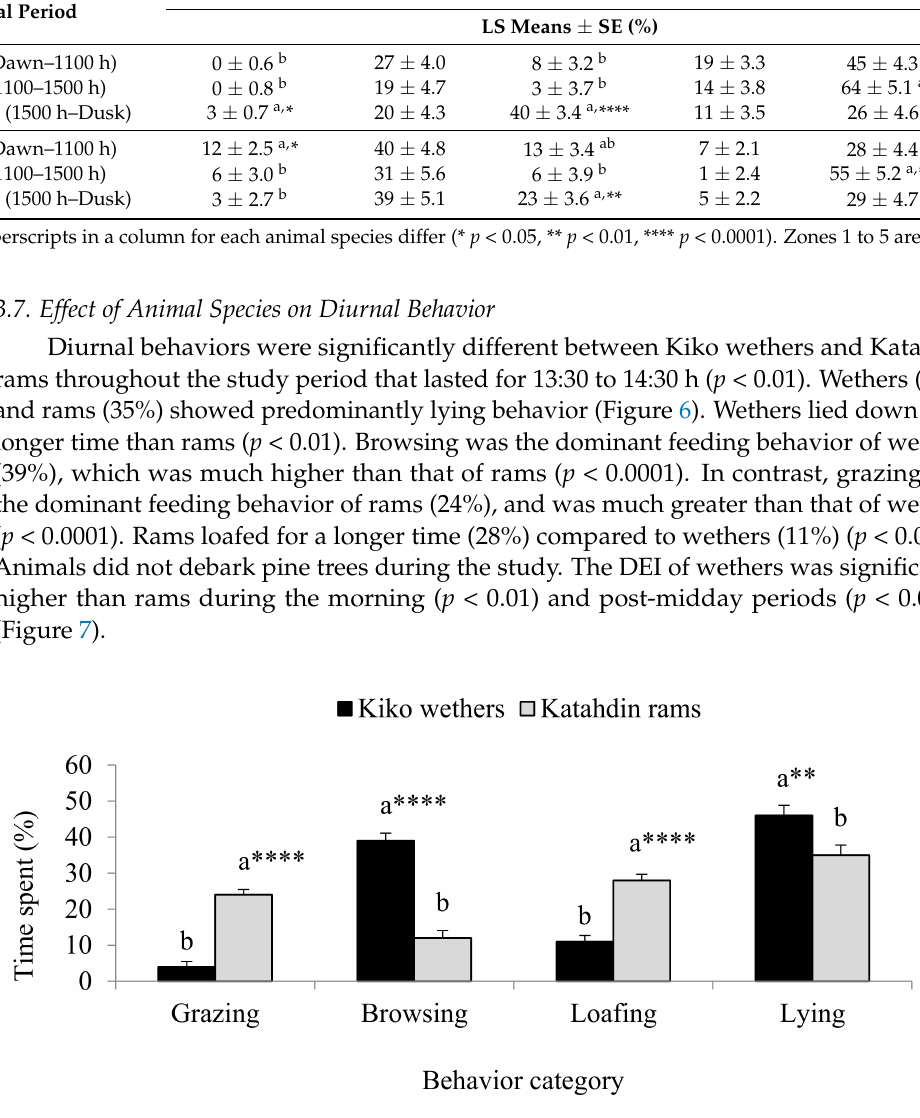
Table 4. Diurnal (dawn–dusk) time spent by Kiko wethers and Katahdin rams in woodlands, June–August 2018. Animal Species